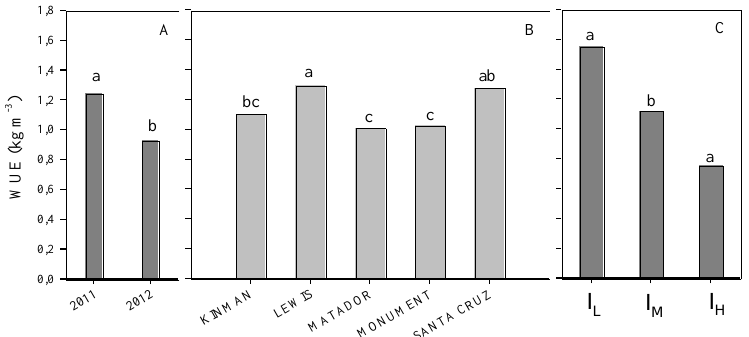
Figure 8. Two-year average water use efficiency (kg grain m −3 ) in guar ( A ) by year across five guar cultivars and three irrigation levels, ( B ) by guar cultivar across three irrigation levels, and ( C ) by irrigation level averaged for five guar cultivars. Within each box, bars with different letters differ for p < 0.05.